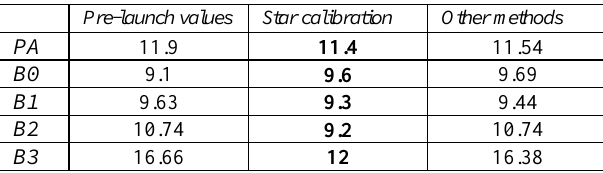
Table 3 : Absolute calibration coefficients (preliminary results)